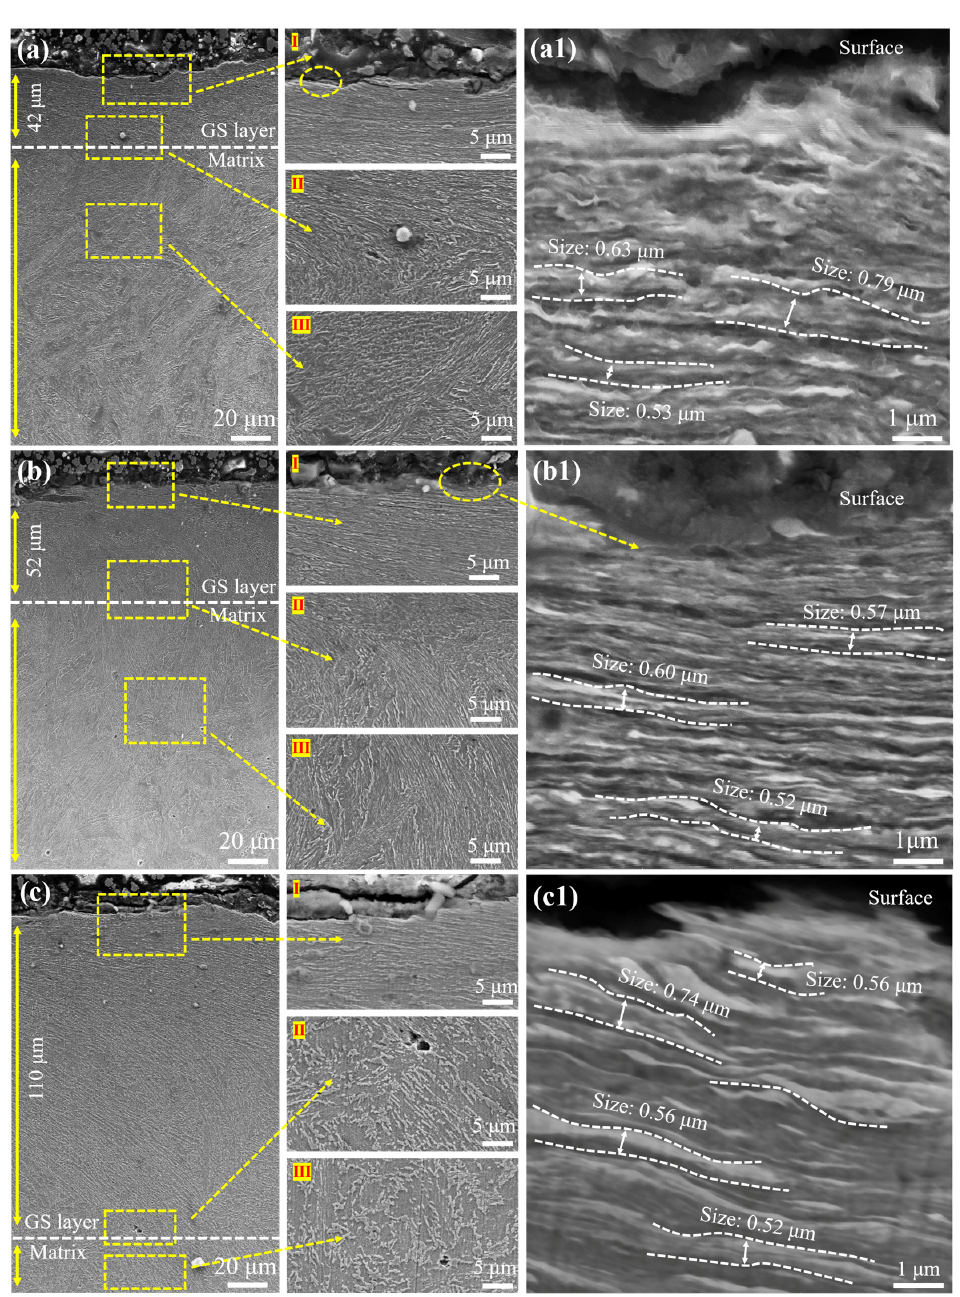
Figure 7. FESEM images of the gradient strain layer of the test steel: ( a , a1 ) 80 km/h, ( b , b1 ) 120 km/h and ( c , c1 ) 150 km/h.